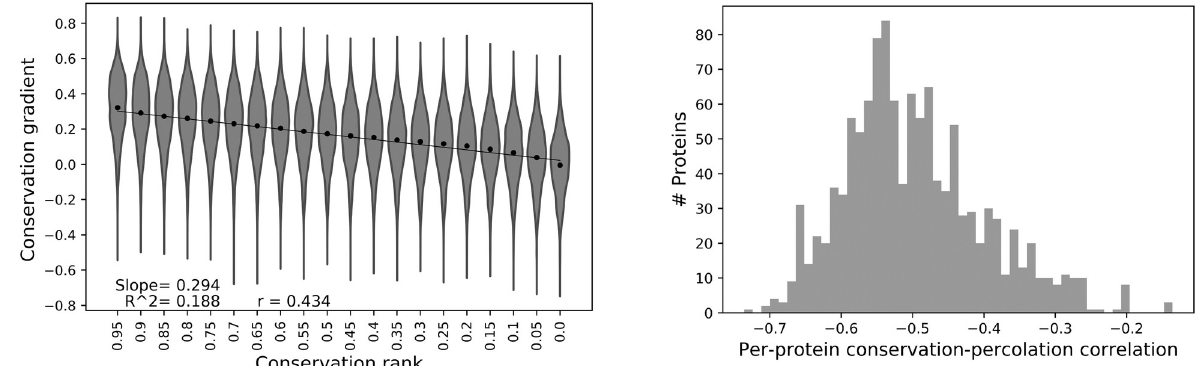
Fig 1. Conservation gradient induced from a protein residue is linearly correlated with its conservation within the protein. (A) Violin plots and respective average of conservation gradient from a residue as a function of conservation rank for all residues in the dataset binned into 20 equally spaced bins of conservation rank along with the linear fit calculated over all residues. (B) Distribution of per-protein Pearson correlation between residues’ conservation ranks and conservation gradients.